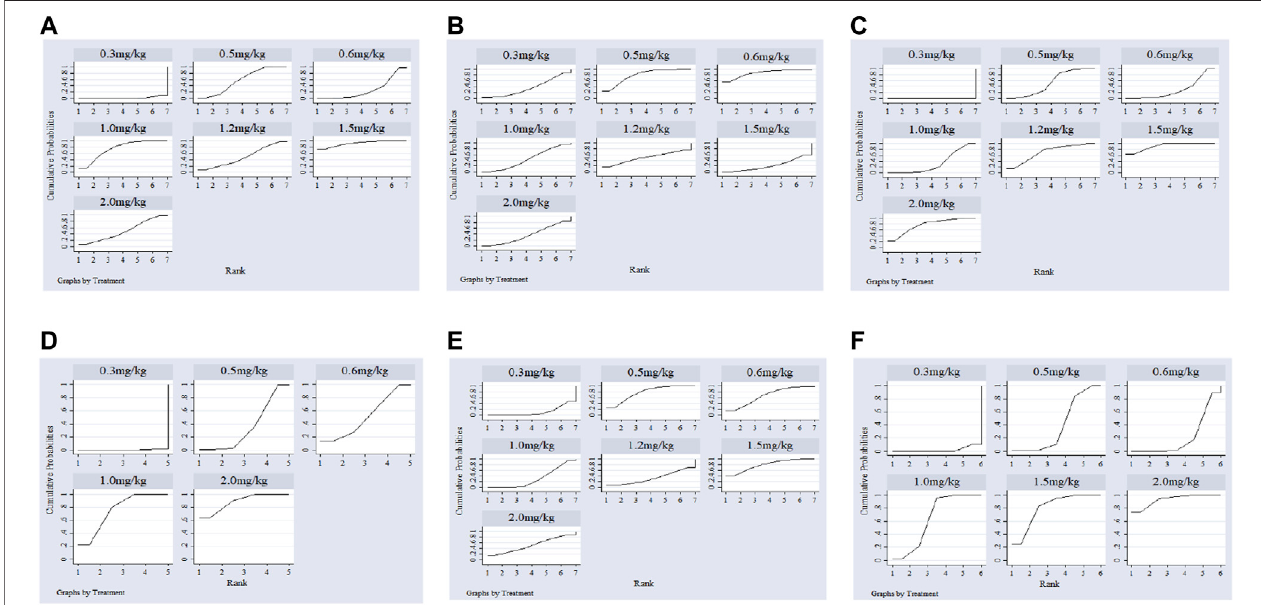
FIGURE 4 | Index ranking chart of different doses of sildena fi l for PPNN.